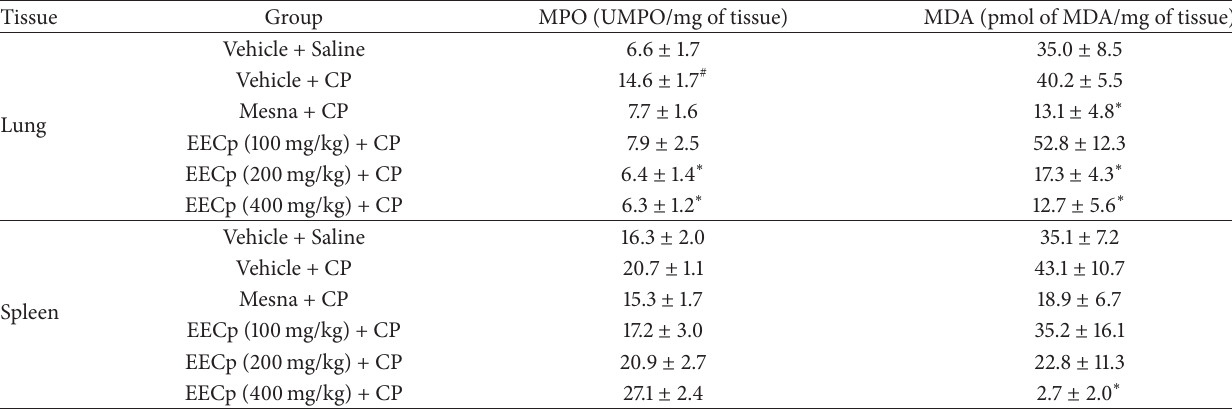
Rats were treated with EECp (100–400mg/kg), mesna (40mg/kg), or vehicle and injected with saline or CP (200mg/kg). After 24h of induction, the MPO activity and malondialdehyde (MDA) formation were determined in the lung or spleen tissues. Data are expressed as mean ± SEM for 𝑛 = 8 rats. # 𝑃 < 0.05 versus respective vehicle + saline group; ∗ 𝑃 < 0.05 versus respective vehicle + CP group.